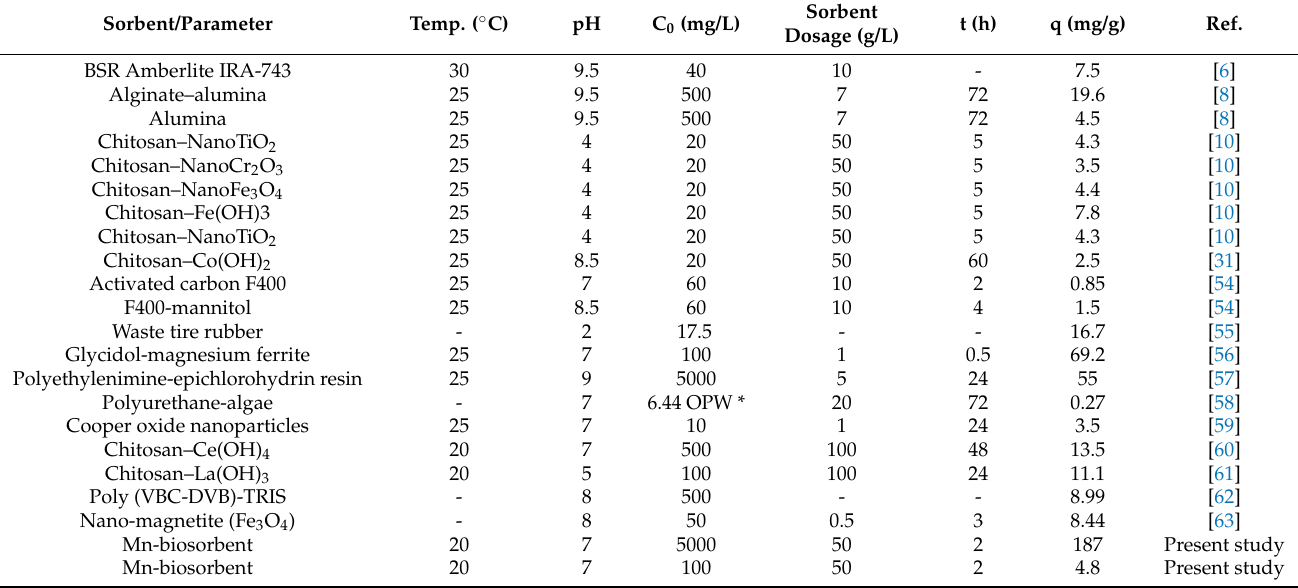
Table 5. Comparison of various boron sorbents reported in